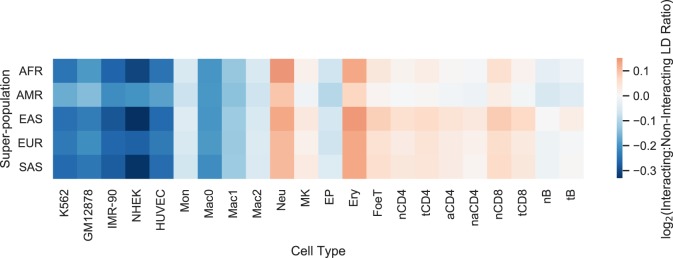
The maximum pairwise LD between SNPs located on the fragments of statistically significant and distance-matched nonsignificant chromatin interactions (interaction LD) was computed for five Hi-C and 17 PCHi-C data sets. The log ratio of mean interaction LD for significant versus nonsignificant interactions quantifies how well LD acts as a proxy for chromatin interactions; a log ratio greater than 0 indicates significant interactions are enriched for SNPs in strong LD. However, the log ratio is near 0 for all cell types and super-populations, indicating that LD is not a sufficient proxy for chromatin interactions. Supplemental Table S2 provides numeric values for this figure; log ratios smaller or larger than 0 are the result of relatively small differences in weak LD.